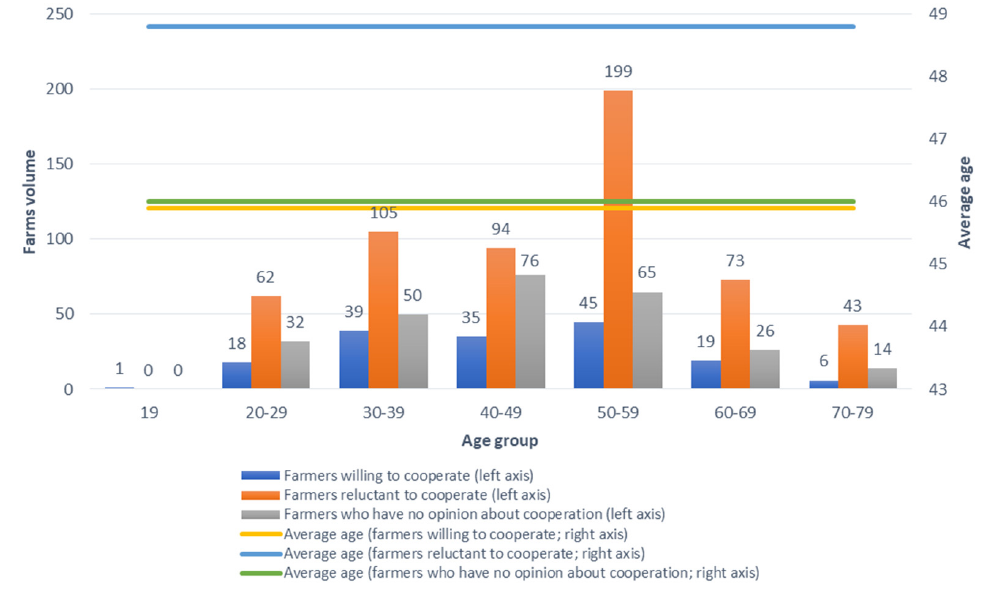
Figure 5. Distribution of smallholder farmers according to their age (N = 1002).